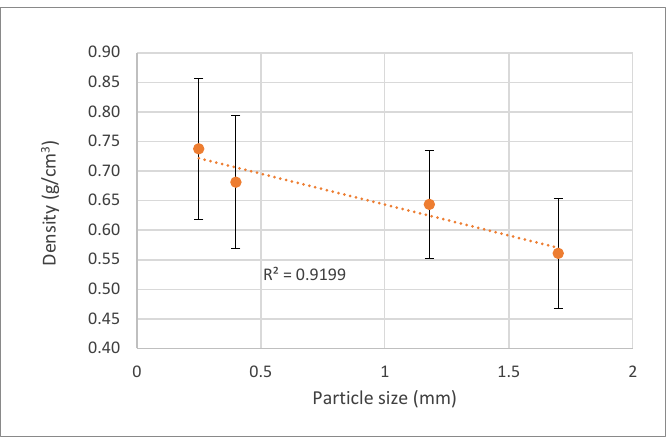
Figure 4. Correlation between board density variation and raw wood particle size.